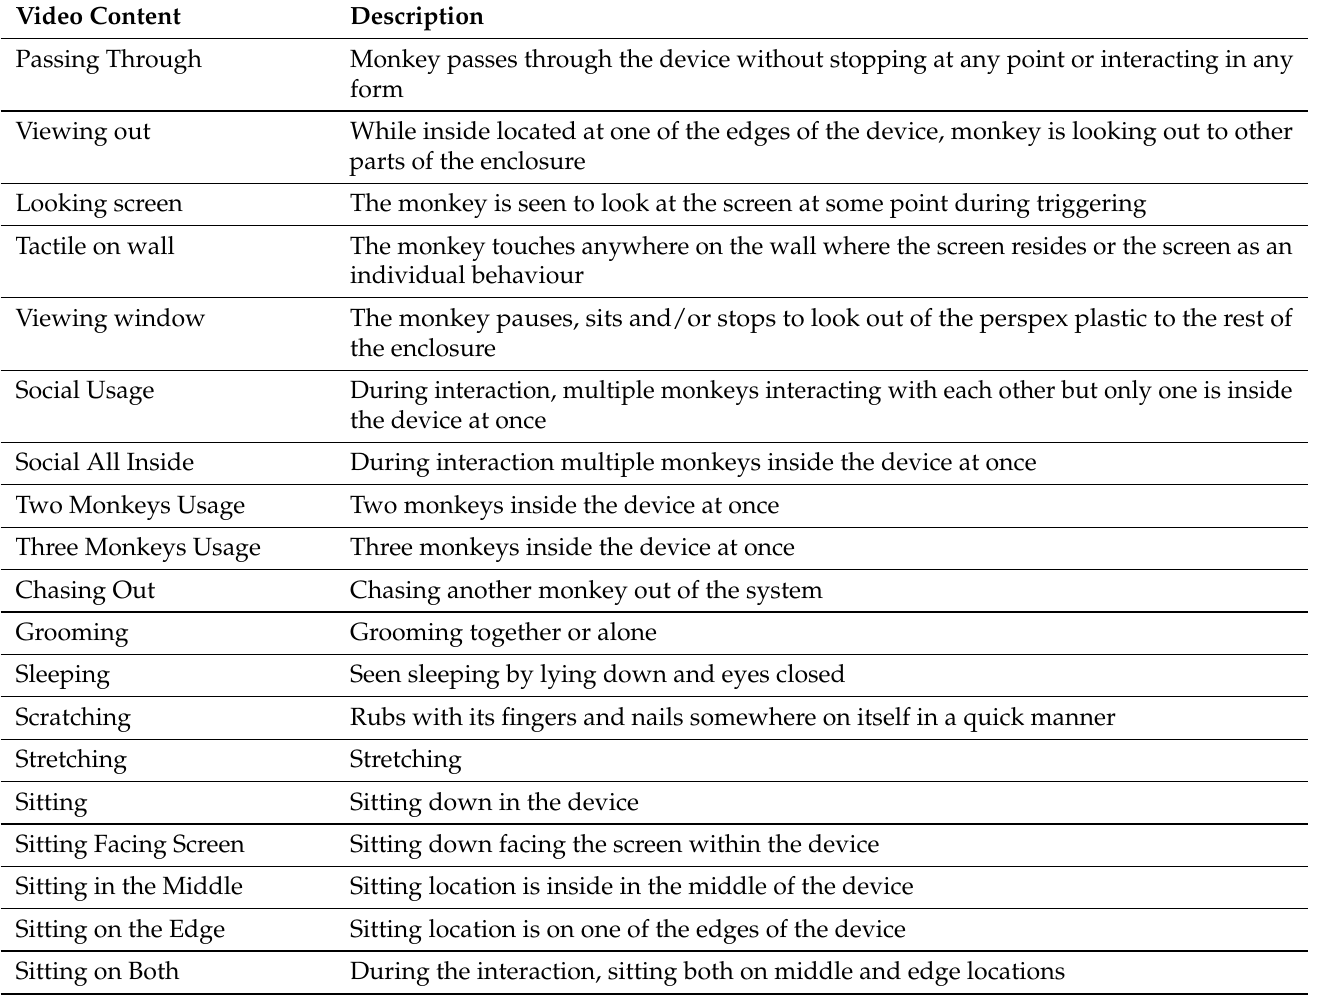
Table 2. Ethogram of behaviours that the saki monkey had with the